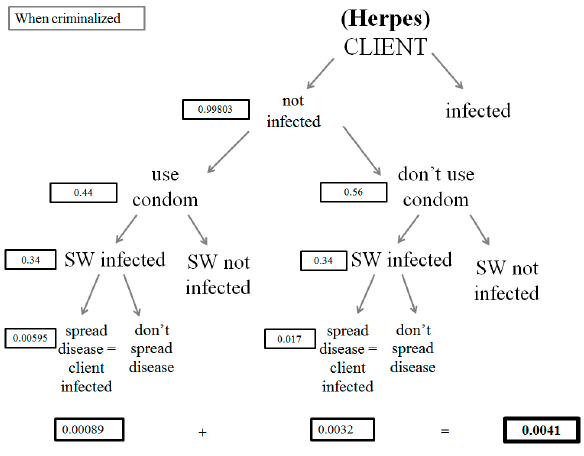
Figure A16. Risk of herpes transmission to a client under criminalization.